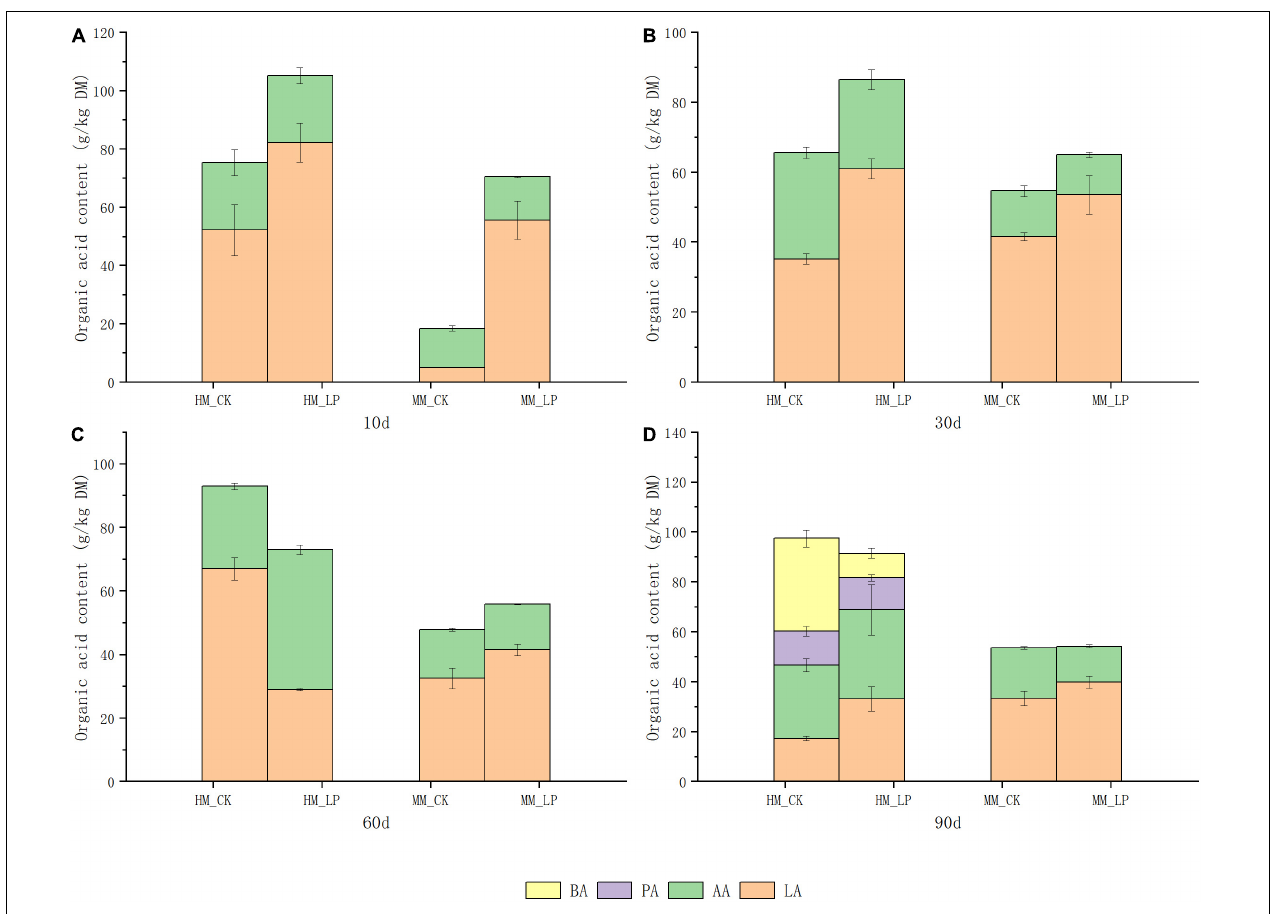
FIGURE 2 | Accumulation of organic acids at 10 (A) , 30 (B) , 60 (C) , and 90 (D) days. HM, not wilted before ensiling; MM, wilted before ensiling; CK, silage without inoculation; LP, silage inoculated with L. plantarum A345.